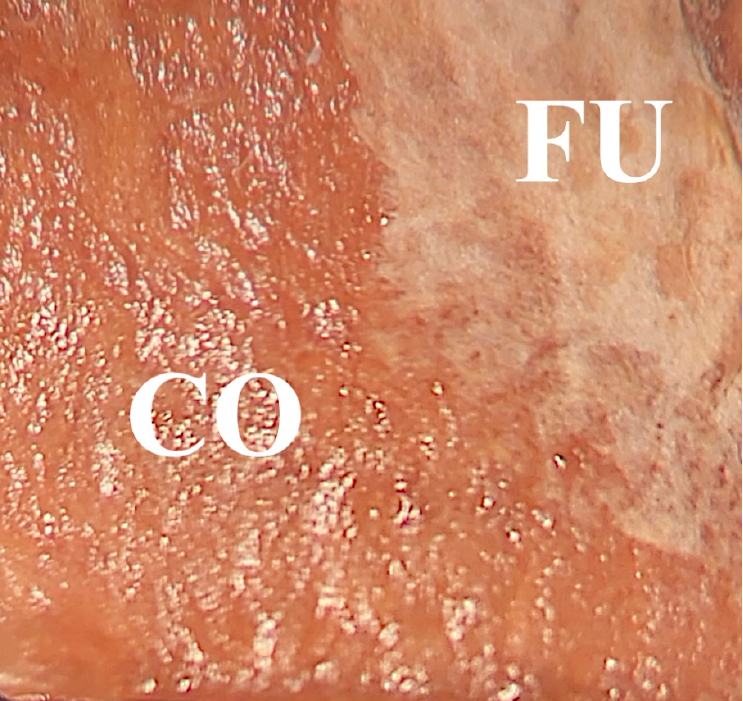
Figure 8. Spots for FTIR spectra acquisition. CO: Mycelium-free area. FU: Mycelium area.